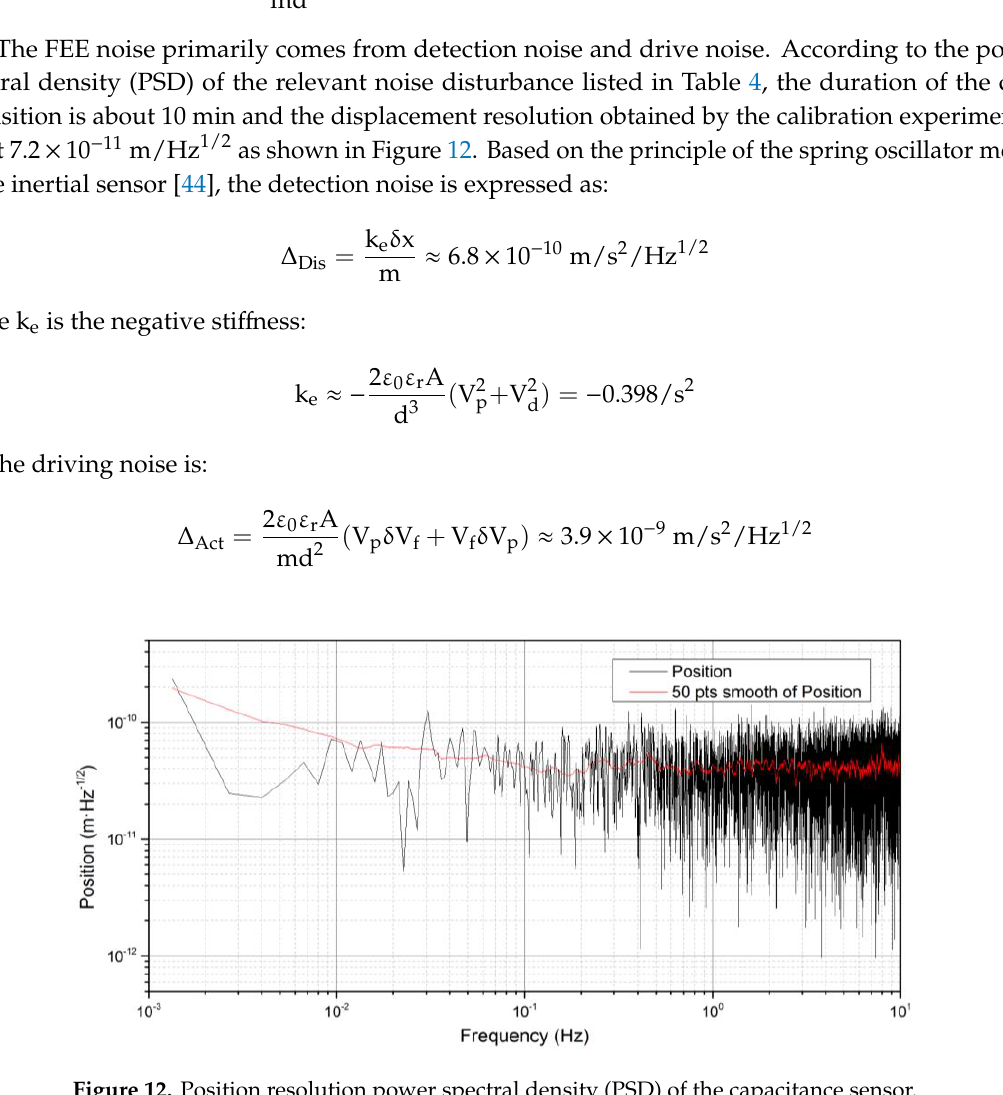
Figure 12. Position resolution power spectral density (PSD) of the capacitance sensor. The total acceleration noise on the TM is listed in Table